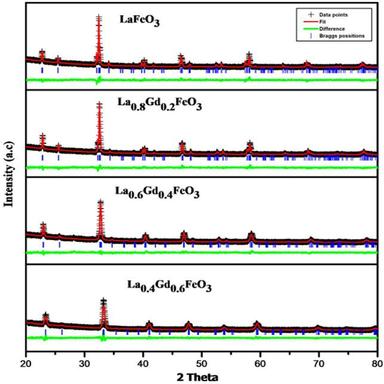
XRD patterns of Gd doped LaFeO3 multiferroic with refined and Rietveld method.